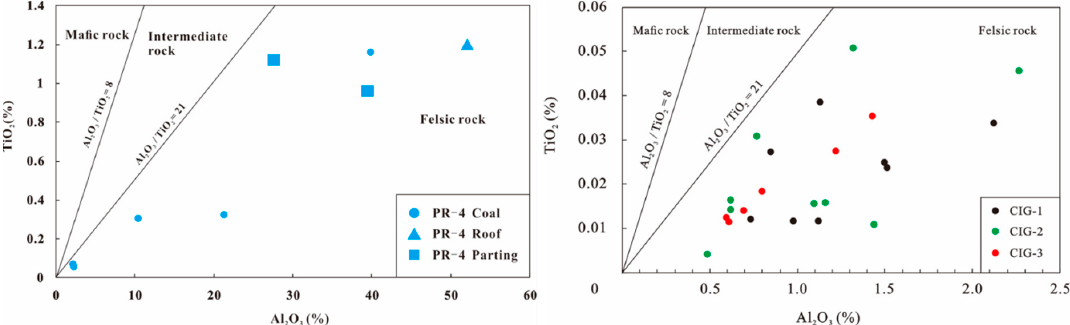
Figure 15. Al 2 O 3 -TiO 2 cross-correlation plot for the Cuijiagou and Puran coals as well as partings and roof.